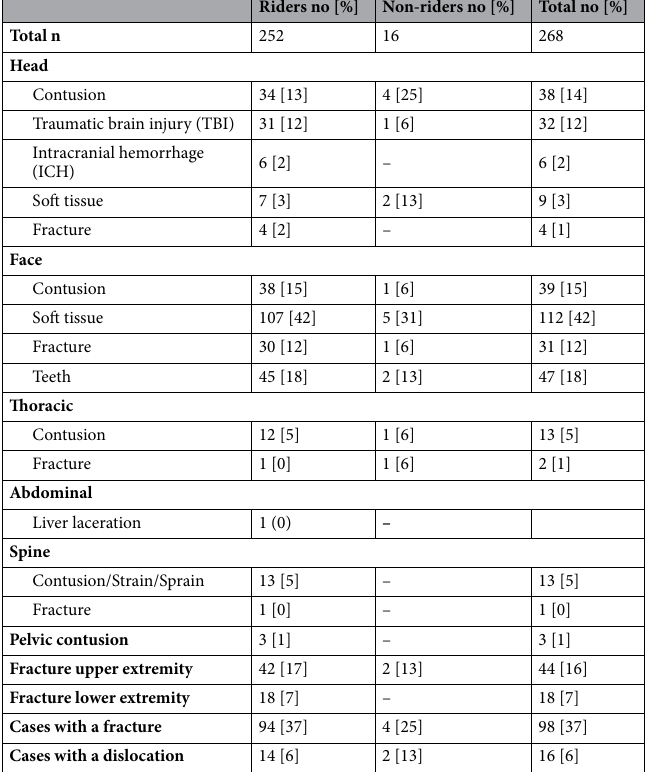
Table 2. Injury patterns of e-scooter riders and non-e-scooter riders according to body regions.